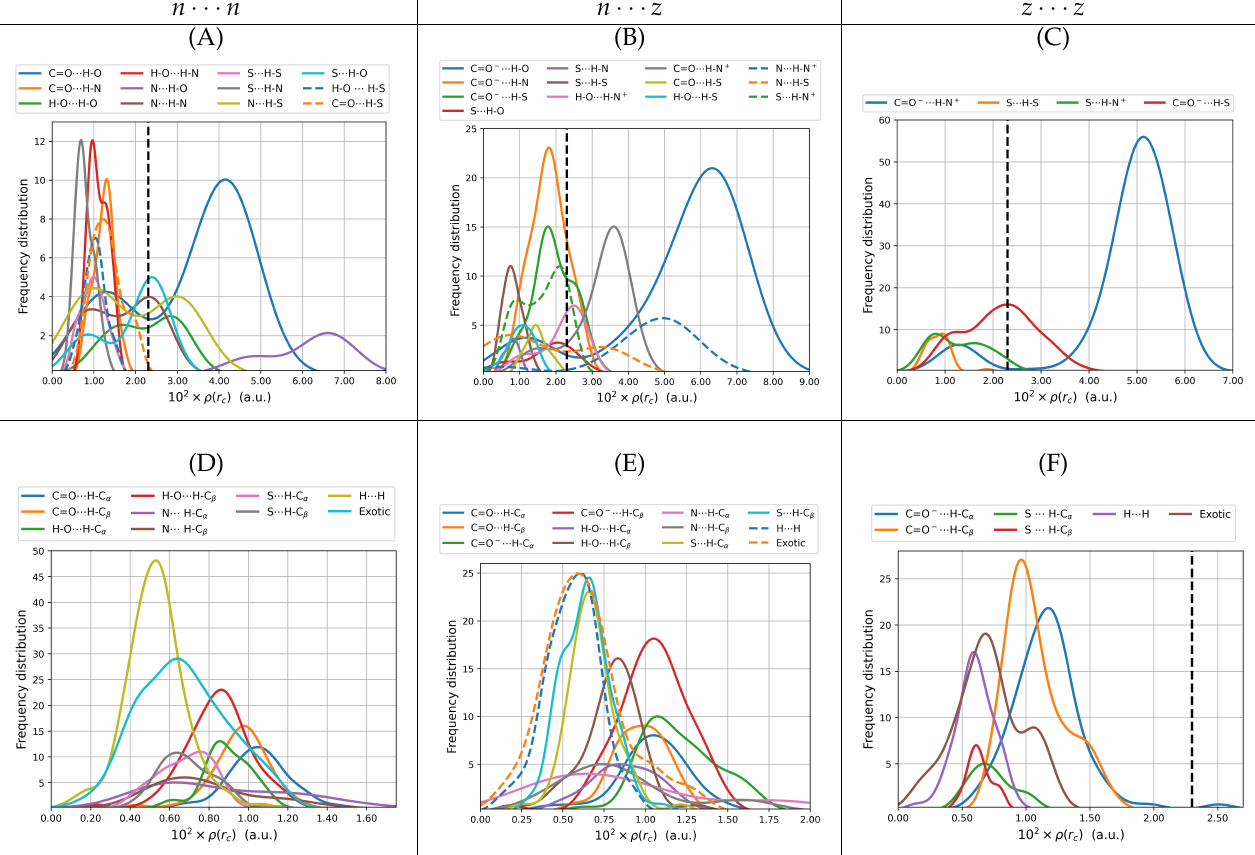
Figure 5. Electron densities at bond critical points for intermolecular contacts for all dimers of cysteine found in this work. The top row shows only primary hydrogen bonds including salt bridges. The bottom row shows secondary hydrogen bonds, dihydrogen bonds, and all exotic interactions. The left column is reserved for the n · · · n dimers (subfigures ( A , D )), the middle column for n · · · z (subfigures ( B , E )) and the right column for z · · · z (subfigures ( C , F )). All values taken from the B3LYP– D3/6–311++G( d , p ) potential energy surfaces with water represented as a continuum solvent. The dashed vertical lines mark the reference value for the gas phase water